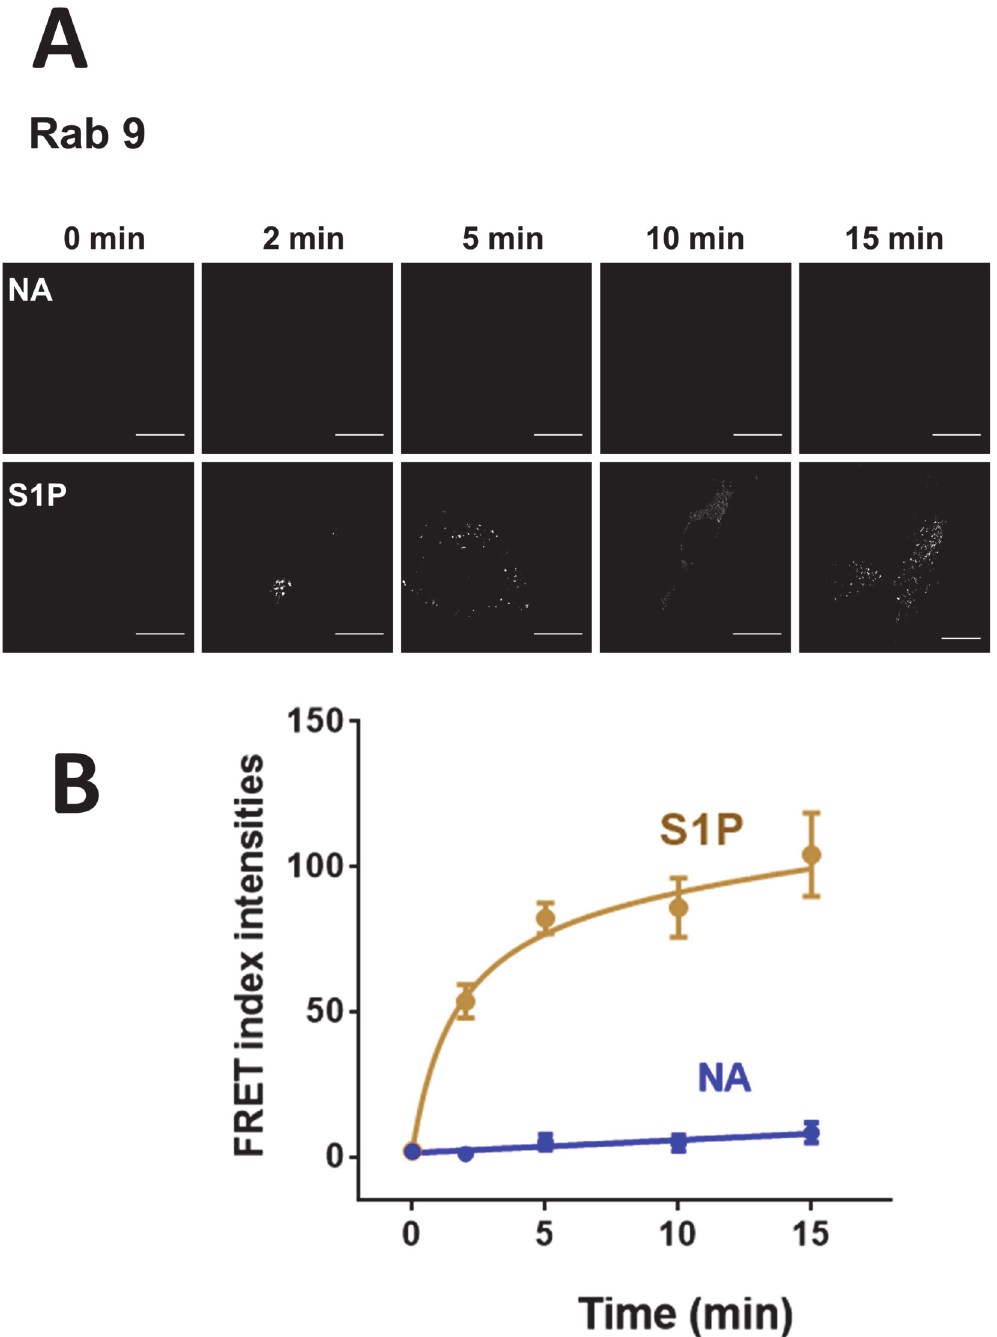
Fig 11. Time-course of the α 1B -adrenergic receptor-Rab 9 interaction. Panel A: FRET index images of cells coexpressing Ds-Red-tagged α 1B - adrenergic receptors and EGFP-tagged Rab 9 treated for the times indicated with 10 μ M noradrenaline (NA) or sphingosine 1-phosphate (S1P). Scale bars: 15 μ m. Panel B: Quantitative analysis of the data presented in Panel A. Plotted are the means and vertical lines representing the S.E.M of 5 – 7 experiments using different cell preparations. Noradrenaline, blue line and symbols; sphingosine 1-phosphate, brown line and